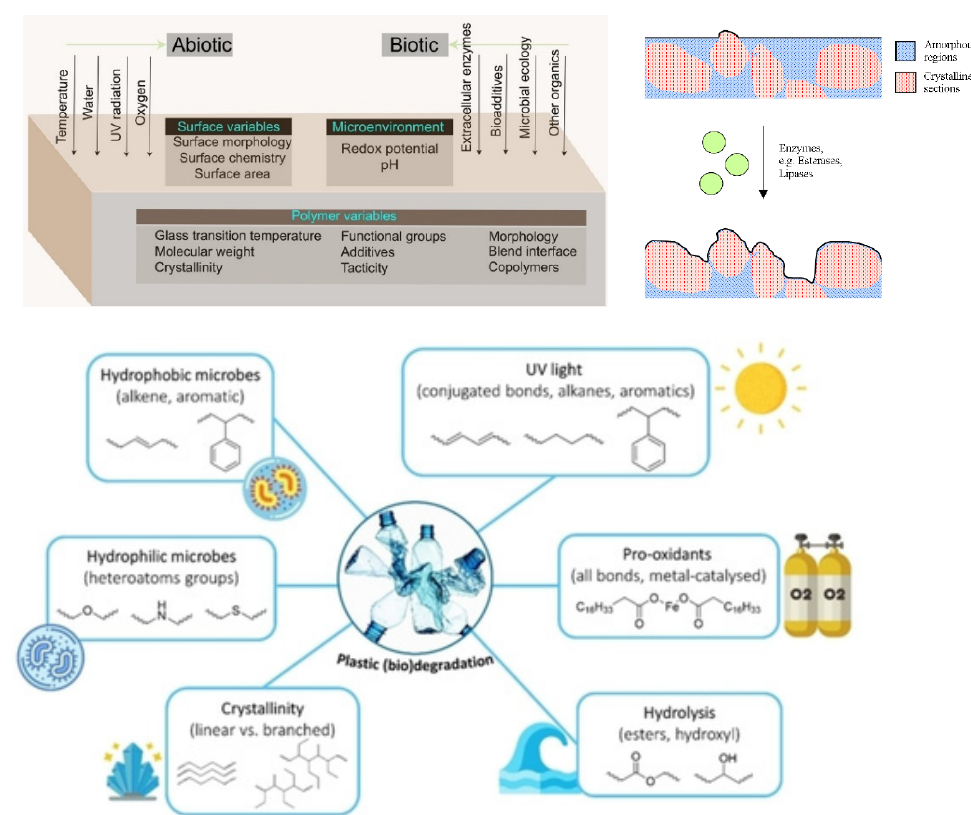
Figure 11. Left : Interplay of biotic and abiotic factors [24]; Right : The effect of polymer crystallinity on enzymatic degradation [259]. Bottom : Important factors and chemical groups impaired during biodegradation [257].